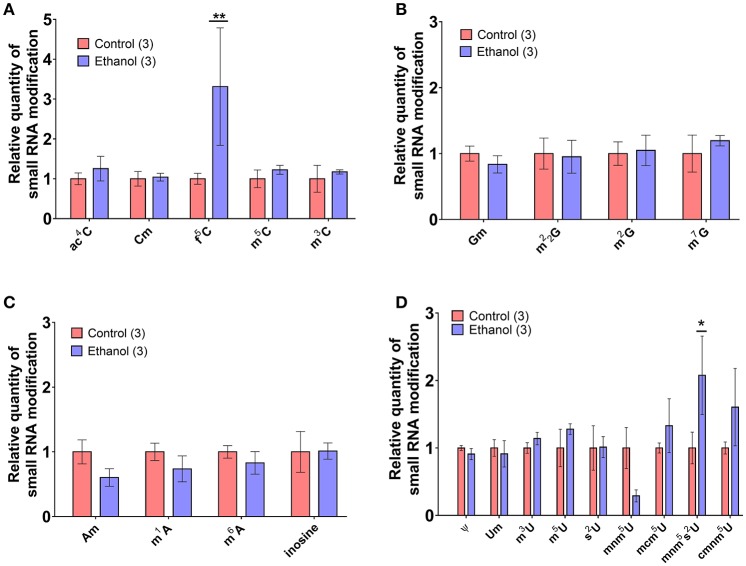
Chronic ethanol alters select RNA modifications in sperm small noncoding RNA. UHPLC-MS/MS was performed on the ~30–40 nt fraction of sperm RNA from chronic ethanol and control exposed groups. Post-transcriptional modifications were examined for each of the parent nucleosides, (A) uridine, (B) cytidine, (C) adenosine, and (D) guanosine. Chronic ethanol increased the uridine modification, 5-methylaminomethyl-2-thiouridine (mnm5s2U) (q < 0.1) and the cytidine modification formylcytidine (f5C) (q < 0.01). Data presented as μ ± SEM bars. N = 3 pooled samples/group. *q < 0.1, **q < 0.01.